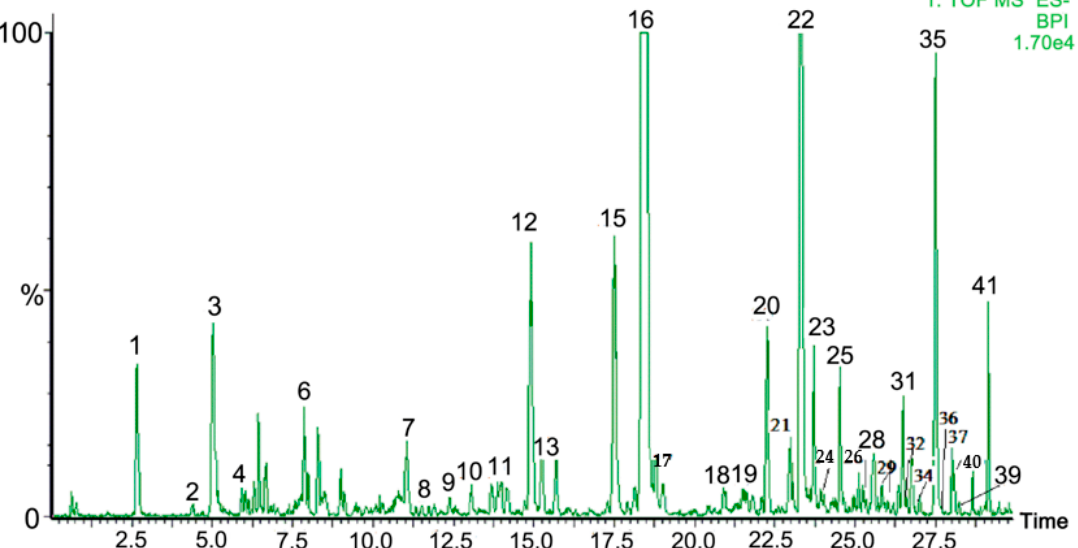
Figure 1. Total ion chromatograms (TIC) of Radix Scrophulariae aqueous extract in the negative ion mode via UPLC-QTOF-MS/MS.